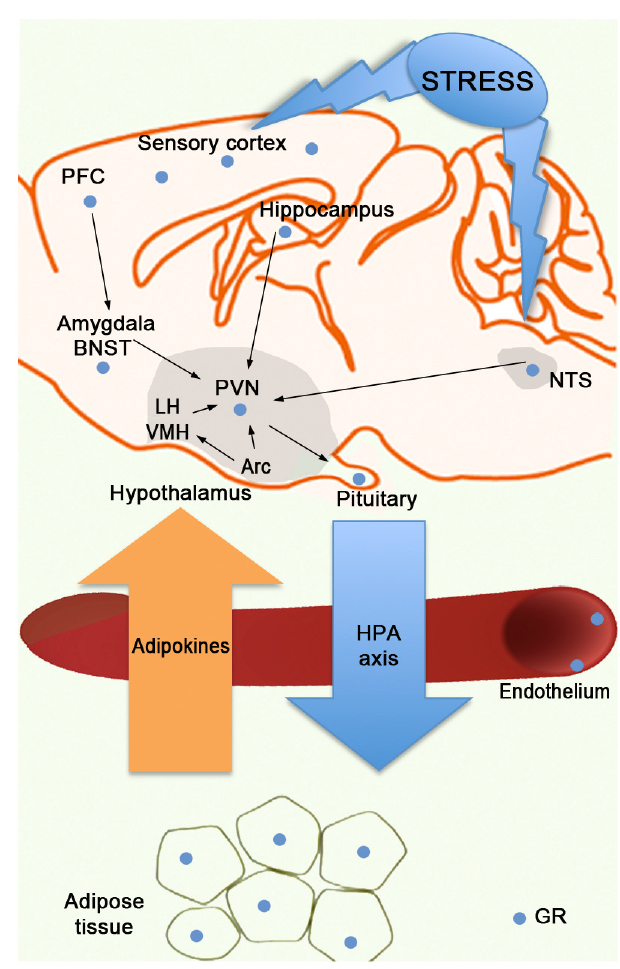
Figure 3. Brain-to-fat signaling axis. Shown is a schematic of the brain and adipose tissue separated by the endothelium. Hypothalamic-pituitary-adrenal (HPA) axis activation promotes glucocorticoid secretion from the brain to the fat. Adipokines secreted from the adipocytes traverse the endothelium and signal to the brain to affect neuronal function. Stress can impact the brain and promote expression of corticotrophin-releasing hormone (CRH) in the paraventricular nucleus (PVN) of the hypothalamus. CRH binds to the pituitary to stimulate the HPA-axis cascade to secrete glucocorticoids to influence the brain and adipocyte function via glucocorticoid receptor (GR) (blue circle). Brain structures that sense stress and signal to the PVN and in turn the pituitary gland are shown and include the sensory cortex, prefrontal cortex (PFC), amygdala/bed nucleus of the strial terminalis (BNST), hippocampus, nucleus tractus solitaries (NTS), arcuate nucleus (ARC), along with the ventromedial hypothalamus (VMH) and lateral hypothalamus